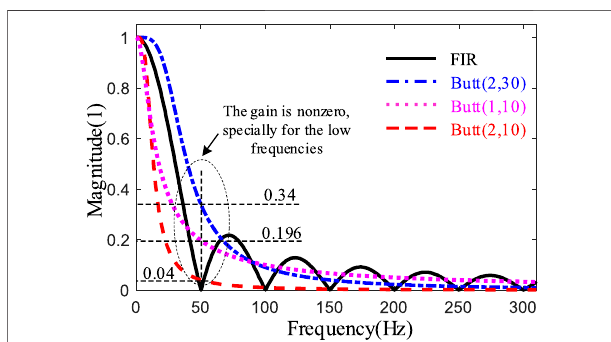
FIGURE 3 | Frequency response of the LPFs.